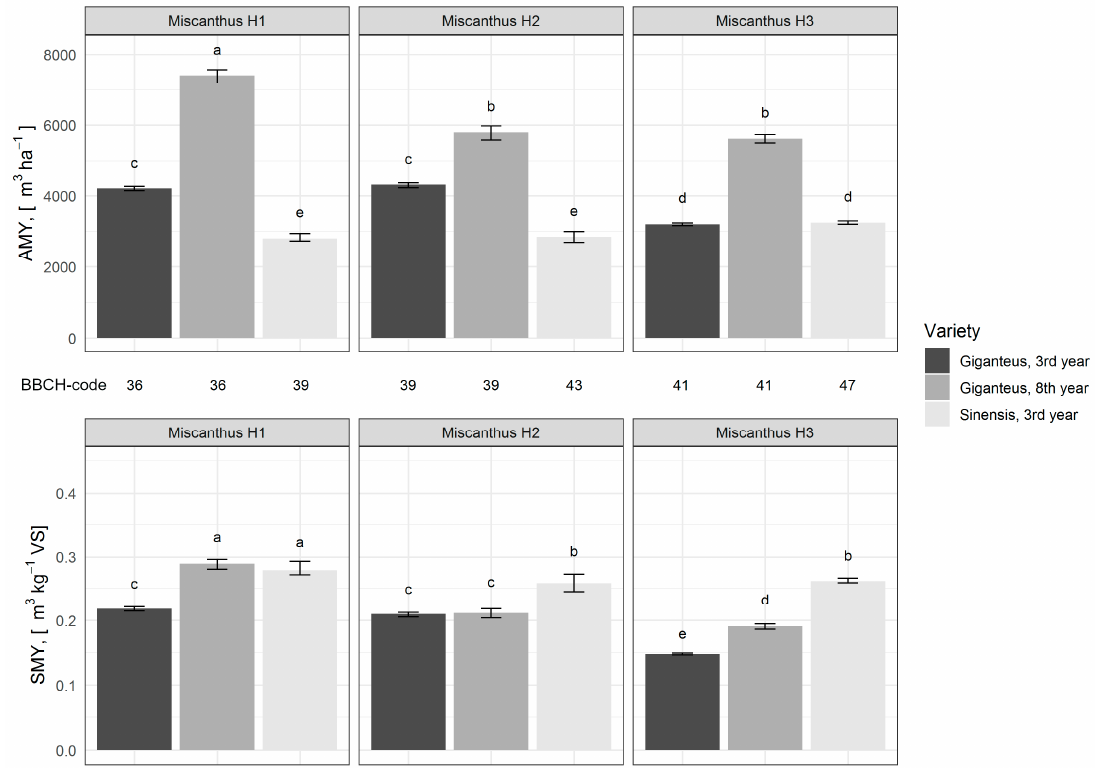
Figure 4. Specific methane yield (SMY) and areal methane yield (AMY) of the miscanthus varieties harvested at H1, H2 and H3 harvesting times, which correspond to a certain BBCH-code related to a specific stage of crop phenological development. The analysed varieties were: (1) Species Giant Chinese Silver Grass: Miscanthus x giganteus J.M. Greef & Deuter ex Hodkinson Renvoiz , the variety name “Osinnii zoretsvit”, referred to as “Giganteus”. (2) Species Chinese Silver Grass: Miscanthus sinensis Anderss. , the variety name “Misiachnyi promin‘”, referred to as “Sinensis”. “Giganteus” from the 3rd and the 8th years of vegetation and “Sinensis” from the 3rd vegetation year were analysed. Histograms are charted based on the mean values; error bars indicate the variability between the three replications. Lower case letters indicate significant differences between the analysed miscanthus samples according to the results of the Tukey test.